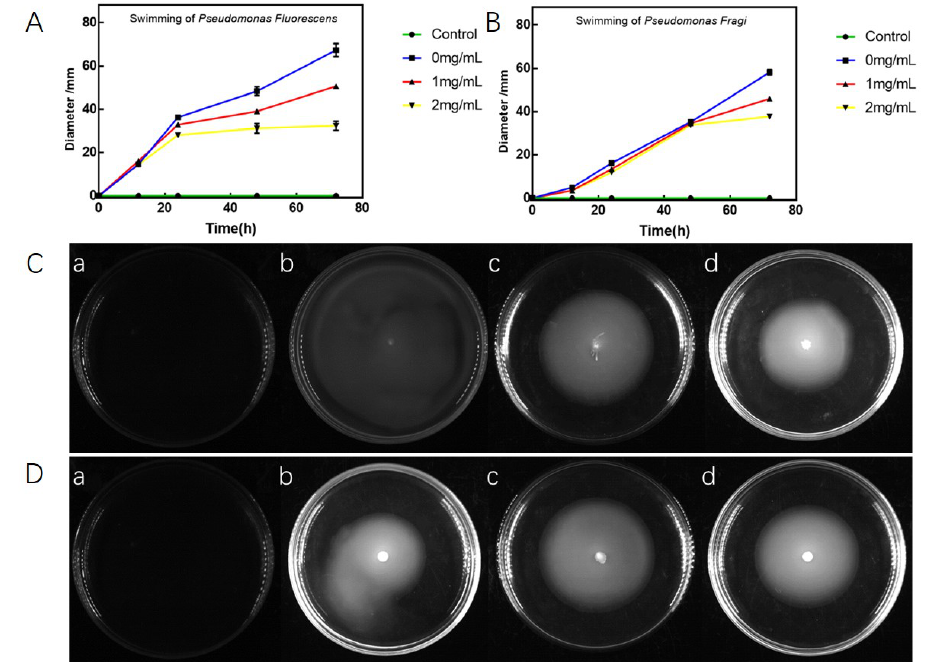
Figure 12. Antibacterial effects of D. algida on the swimming of the target Pseudomonas , where ( A , C ) are the diameter and appearance, respectively, of the inhibition zone of P. fluorescens , while ( B , D ) are the diameter and appearance, respectively, of the inhibition zone of P. fragi . The symbols (a–d) in the subfigures ( C , D ) represent the control group, 0 MIC, 0.5 MIC, and 1 MIC, respectively. The data are shown as mean ± SD ( n =